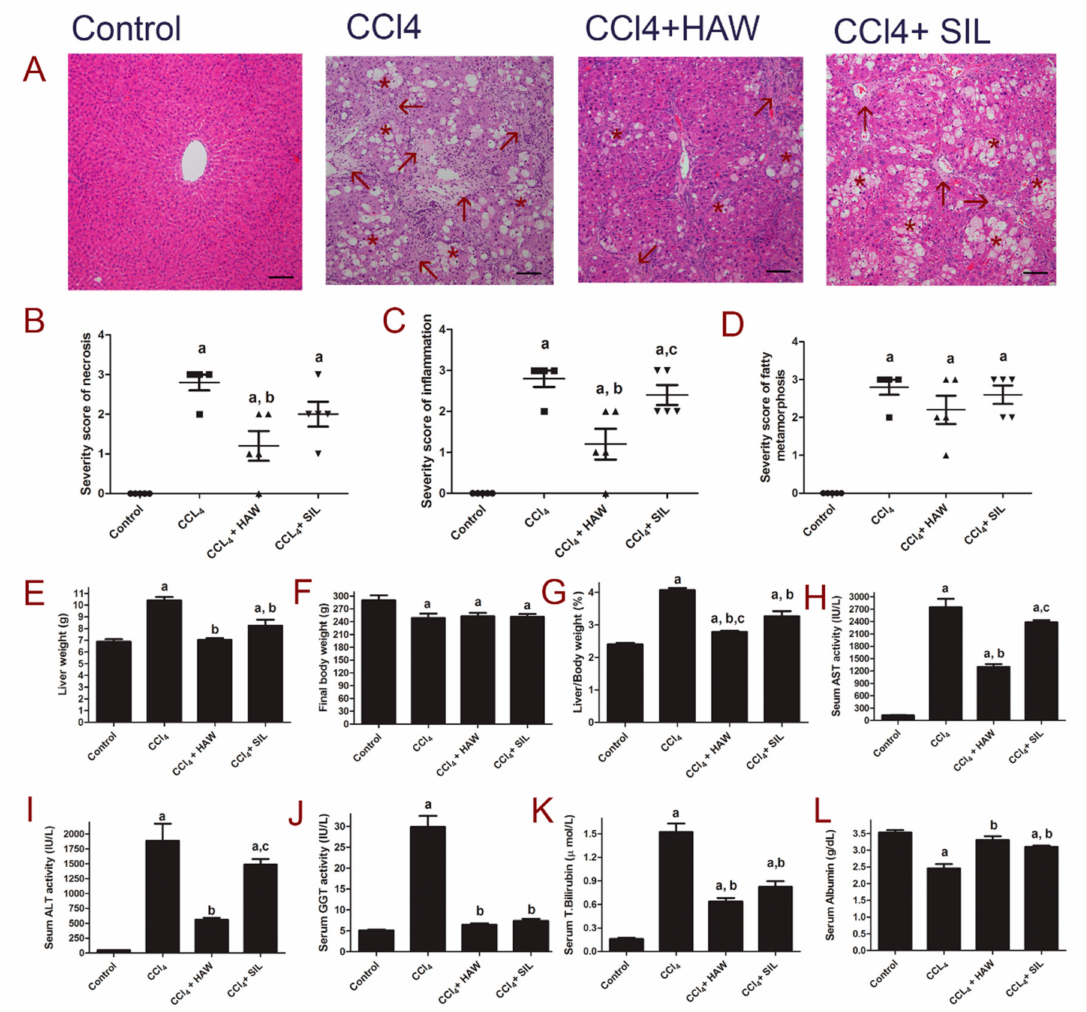
Figure 1. E ff ects of Hawthorn (HAW) on CCl4-induced liver damage in rats. ( A ) representative images of hematoxylin and eosin (H & E)-stained hepatic sections of the di ff erent groups (100 × ), Scale bar equals 100 µ m. Histopathological evidence of CCl4-induced liver damage in rats showing area of necrosis with inflammatory cell infiltration (arrow), and di ff use fatty change (star), ( B ) severity score of necrosis, ( C ) inflammation, and ( D ) fatty metamorphosis. ( E ) liver weight, ( F ) body weight, and ( G ) liver / body weight ratio. Serum markers of liver damage aspartate aminotransferase (AST) ( H ), alanine aminotransferase (ALT) ( I ), gamma-glutamyl transferase (GGT) ( J ) activities and total bilirubin ( K ), and albumin ( L ) levels. Data are presented as means ± SEM. ( n = 6 per group). a is p < 0.05 vs. control group, b is p < 0.05 vs. CCl4 group, and c is p < 0.05 vs. HAW